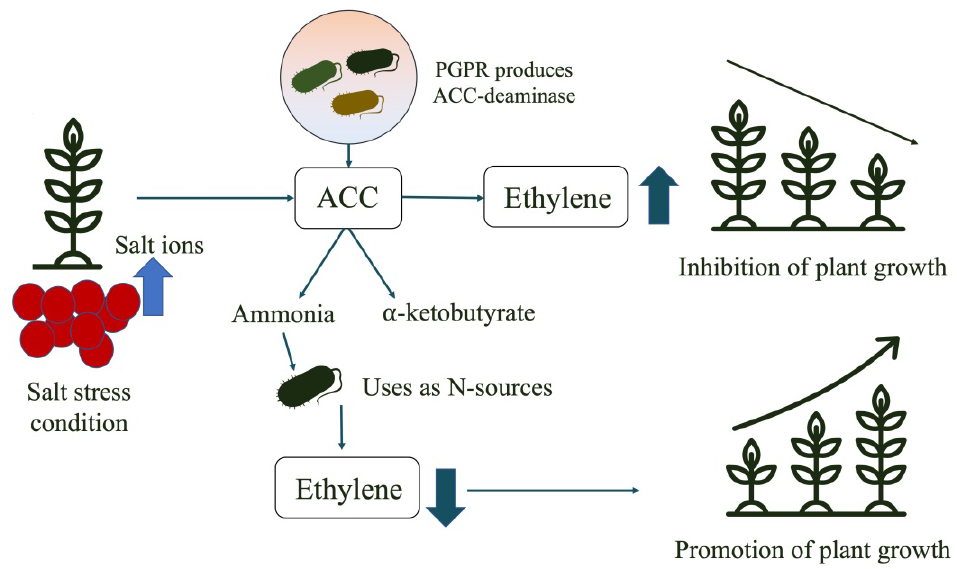
Figure 4. Plant growth promotion in arid soils through ACC-deaminase producing bacteria (ACC:1-aminocyclopropane-1-carboxylic acid).